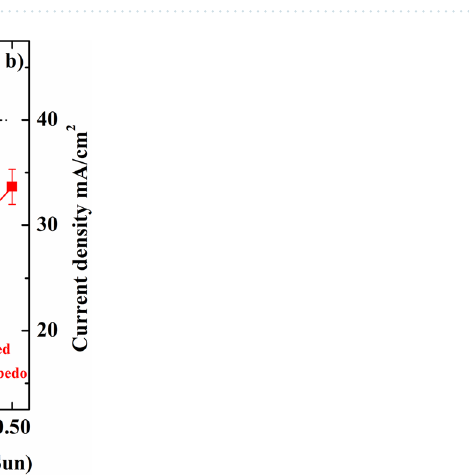
Figure 5. ( a ) A photo image of a solar cell Zig for bifacial 4-terminal tandem solar cell measurement. ( b ) The solar cell Zig with an a-Si:H/c-Si HJ solar cell. ( c ) A real image of the semitransparent PVK solar cell. ( d ) A configuration of the front and albedo light source; the distance between the cell’s holder and the albedo light source can be adjusted. ( e ) The solar cell Zig with PVK/c-Si HJ tandem solar cell and bi-directional light irradiation turned on. ( f ) The real image from back-side view of the bifacial 4-terminal PVK/c-Si HJ tandem solar cell with light source turned on.